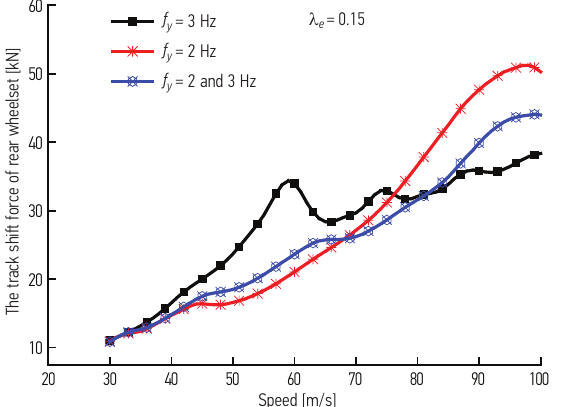
Fig. 14. The track shift forces with the different suspension frequencies at λ e is 0.15